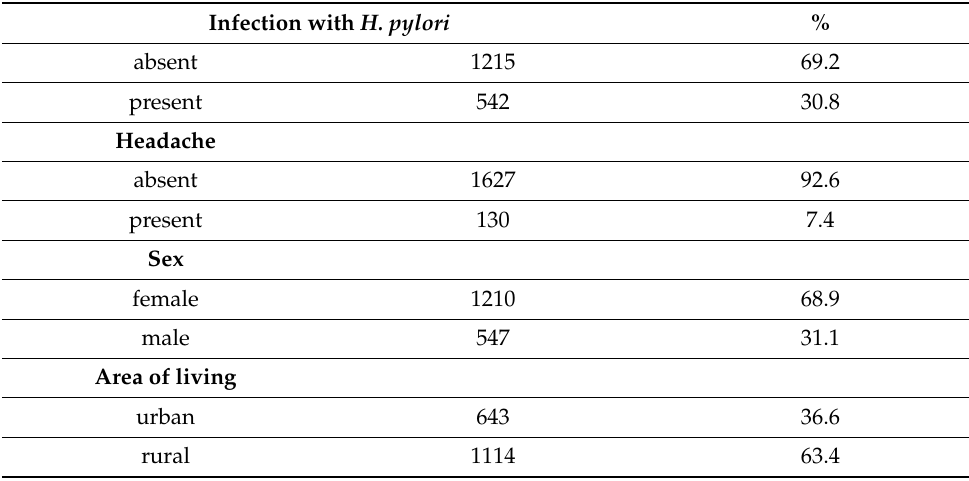
Table 1. Study group presenting or not presenting H. pylori